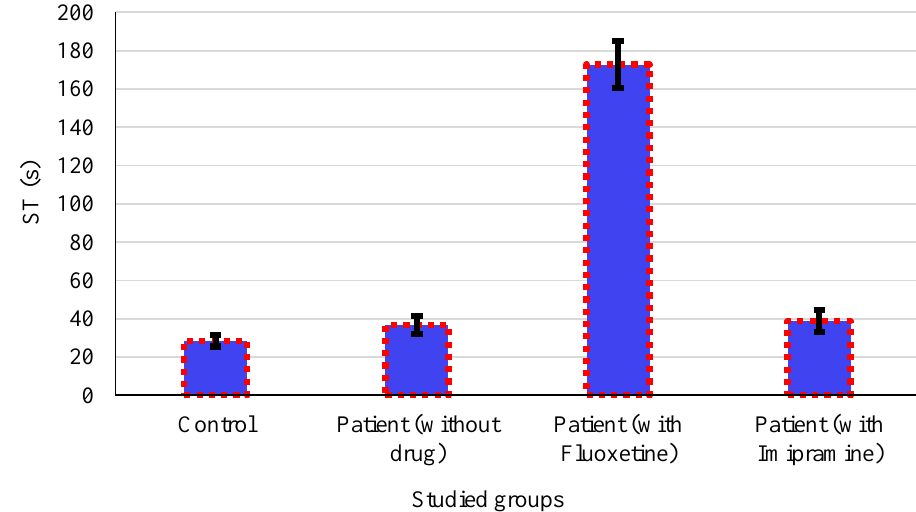
Fig. 5. Comparison of the swimming time between studied groups